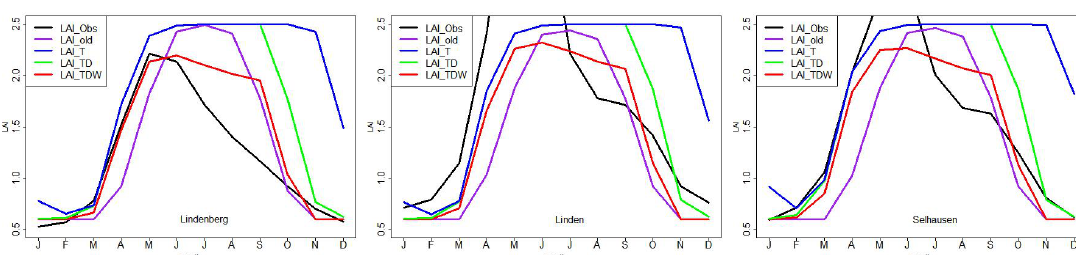
Figure 3. Mean (1999–2015) annual cycle of LAI. Results with the standard phenology(_old, –), with only the dependence on temperature implemented (_T, –), with the dependence on day length added (_TD, –), with the fully implemented new phenology (_TDW, –), and satellite observations (_Obs, –) are shown at the three experimental domains Lindenberg, Linden, and Selhausen.